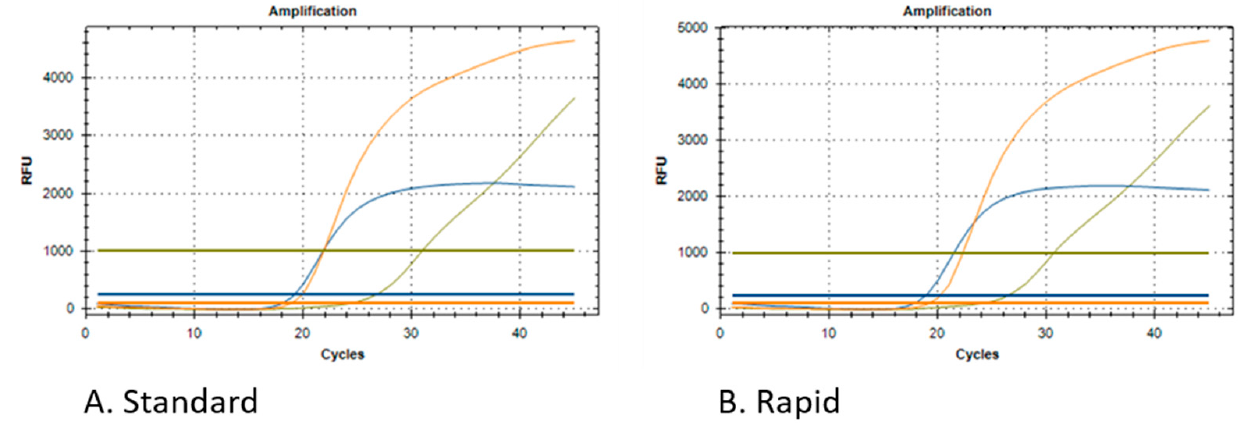
Figure 4. Examples of the qPCR curves obtained from the analysis of the same samples after extraction with the standard ( A ) and rapid ( B ) kits.